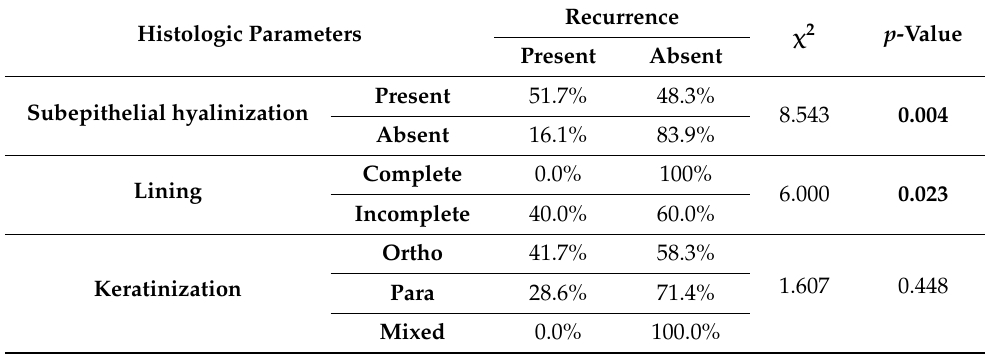
Table 2. Comparison of correlation of histologic parameters with recurrent